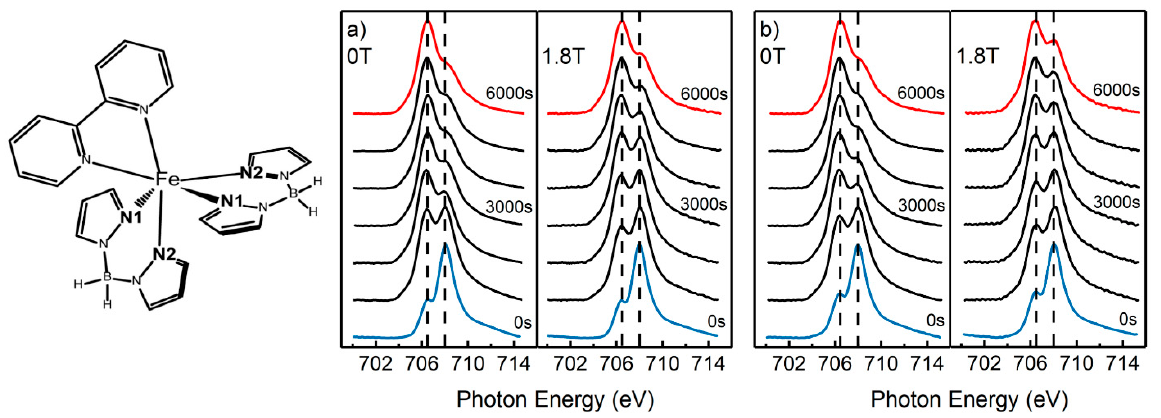
Figure 1. The time evolution of the X-ray absorption spectra of [Fe{H 2 B(pz) 2 } 2 (bipy)] thin films, on NiCo 2 O 4 (111), with and without an applied 1.8 T magnetic field, under a constant incident X-ray fluence at ( a ) 300 K and ( b ) 200 K. The spectra in blue are indicative of a film in a largely low-spin state (roughly 30% high-spin), whereas the spectra in red are largely indicative of a high-spin state. On the left is a schematic of [Fe{H 2 B(pz) 2 } 2 (bipy)] (H 2 B(pz) 2 = bis(hydrido)bis(1H-pyrazol-1-yl) borate, bipy = 2,2’-bipyridine). Hydrogens are omitted for clarity.